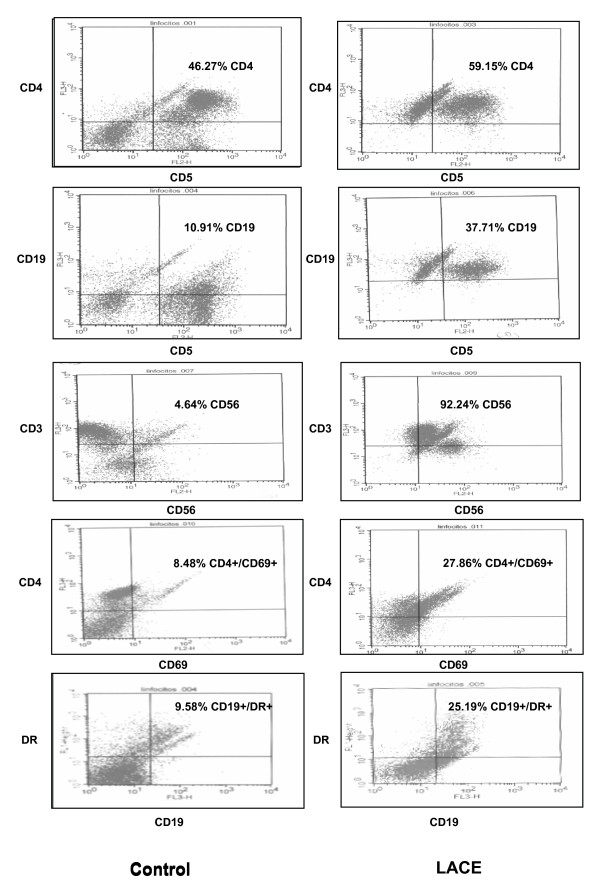
Subpopulation analysis in PBLs treated with LACE. PBLs treated or not with LACE were analyzed and results indicate an increase in CD4, CD19, and CD3-CD16-CD56 positive cells. This experiment was repeated at least three times and gave similar results.